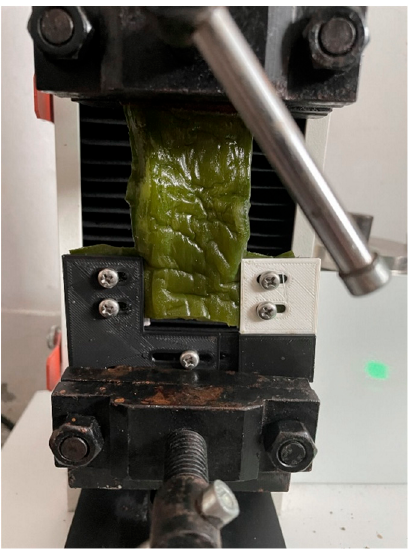
Figure 10. Schematic diagram of stem–leaf separation test.